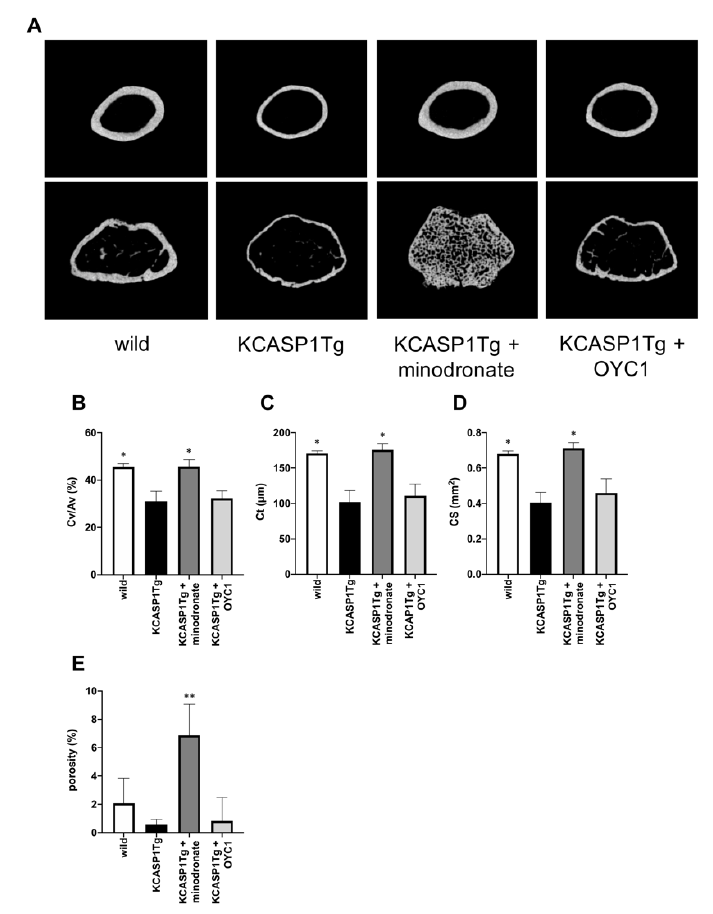
Figure 4. Analysis of cortical bone structure by µCT. The cortical bone structure of KCASP1Tg mice treated with or without minodronate or OYC1 was evaluated by µCT ( n = 4 per each group, ( A )). The cortical bone volume per all bone volume (Cv/Av) showed a 32% reduction in KCASP1Tg mice, but minodronate restored the wild-type level ( B ). The cortical thickness (Ct) and cortical bone section area (CS) at the femoral diaphysis were significantly decreased in KCASP1Tg mice compared to wild-type mice ( C,D ). In KCASP1Tg mice, the porosity was inconspicuous in the diaphyseal part, and decreased at the distal femur metaphysis; however, the difference was not significant ( E ). All data are expressed as mean ± SD. *; p < 0.05, **; p < 0.01 compared to KCASP1Tg mice by Mann – Whitney test.